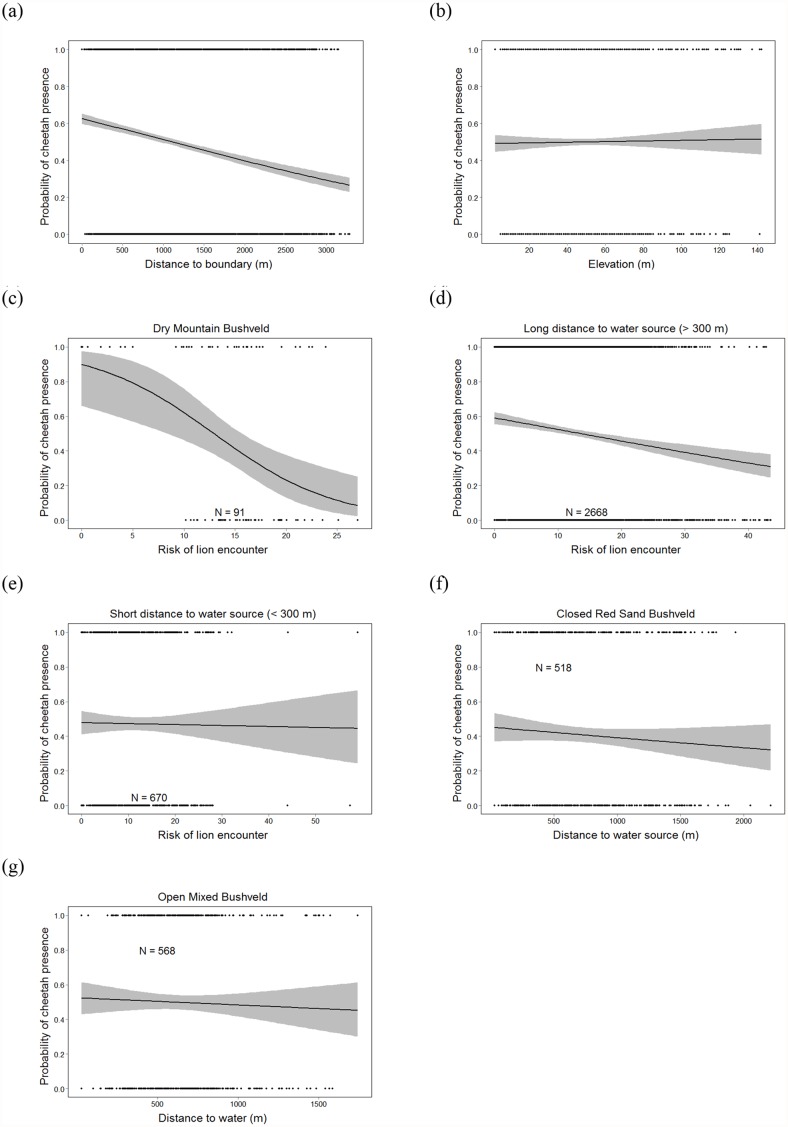
Probability of cheetah presence within their home range in relation to: (a) distance to the boundary; (b) risk of encountering a lion in dry mountain bushveld; risk of encountering a lion at (c) long and (d) short distances to water sources; (e) distance to water sources within closed red sand bushveld.Fitted lines are displayed with 95% confidence intervals.